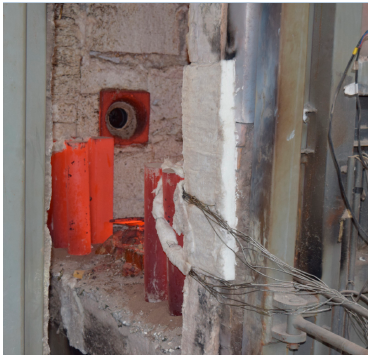
Figure 17. The end of the fire test.